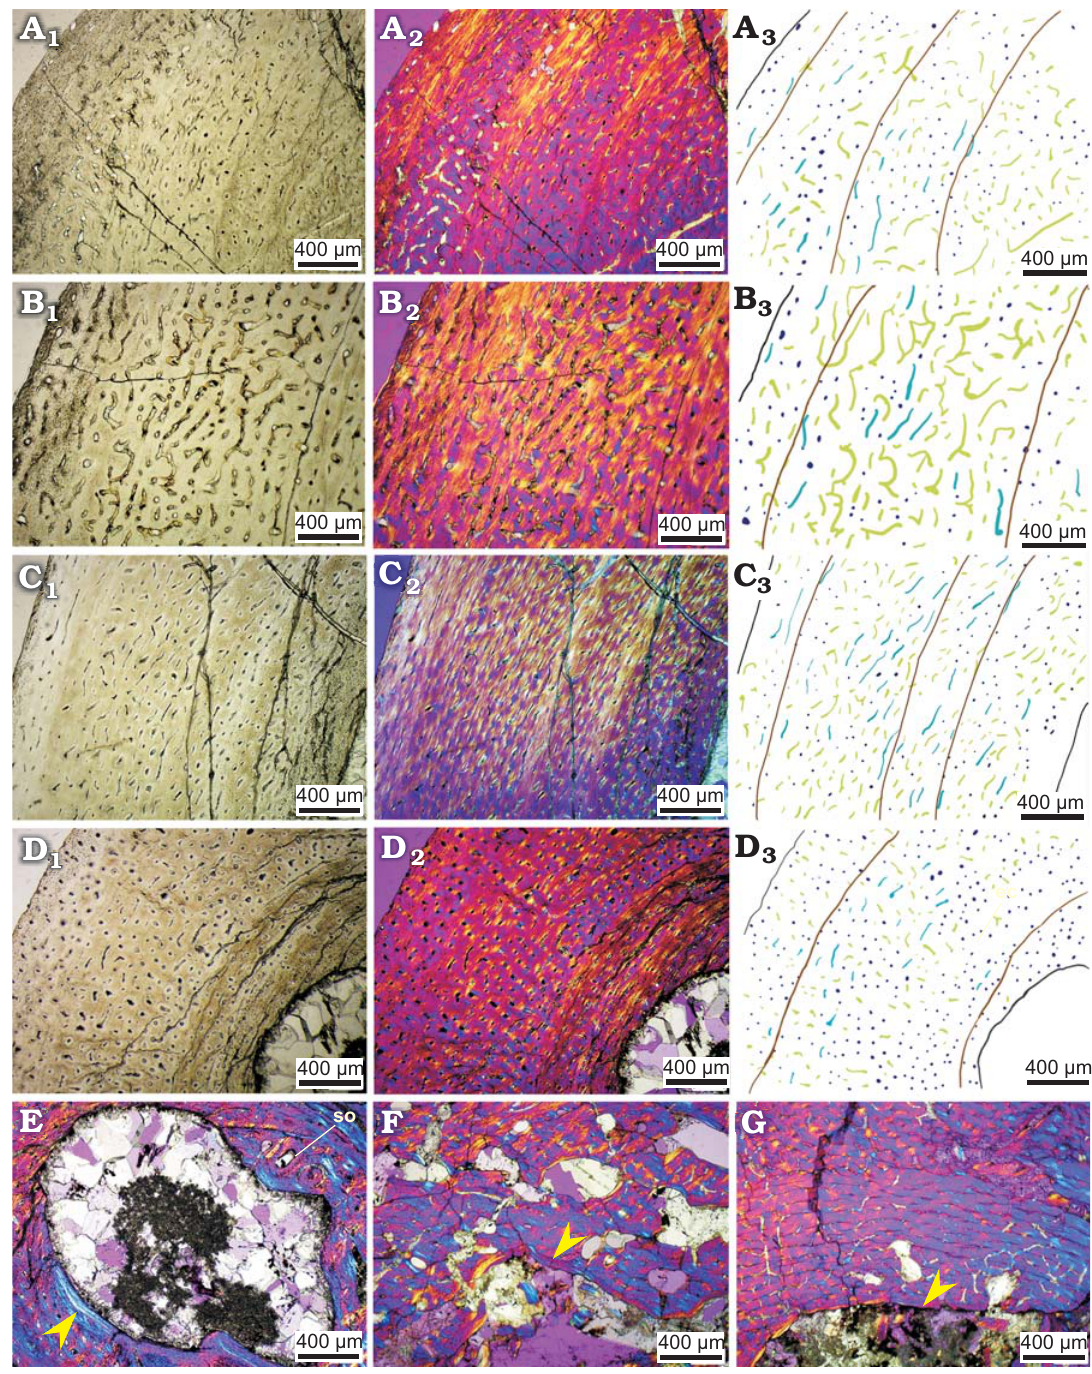
Fig. 6. Bone microstructure in subadult ceratopsian dinosaur Psittacosaurus lujiatunensis Zhou, Gao, Fox, and Chen, 2006 from western Liaoning, China, Early Cretaceous. Mid-diaphyseal transverse section of right radius (IVPP V18344, A ), left femur (IVPP V18344, B ), left tibia (IVPP V14748, C ), left fibula (IVPP V14748, D , E ), left femur (IVPP 18344, F ), left tibia (IVPP V18344, G ). E–G show the endosteal bone (arrows). Photographs in regular transmitted light (A 1 –D 1 ), elliptically polarized light (A 2 –D 2 , E–G); line drawings (A 3 –C 3 ) showing longitudinal vascular canals (navy), reticular vascular canals (green), radial vascular canals (red), and LAGs (brown lines). Abbreviation: so, secondary